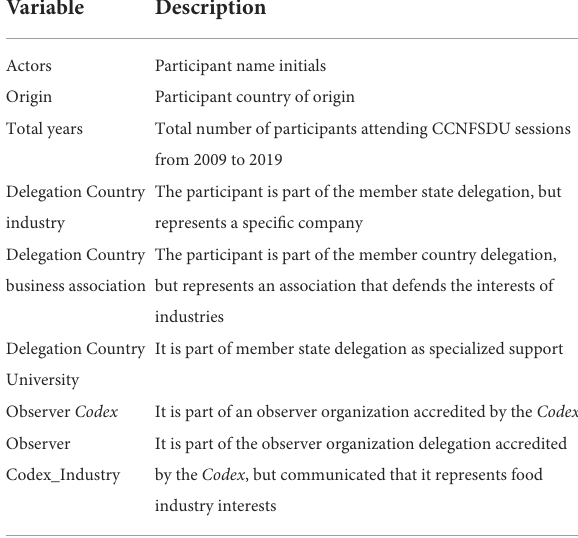
TABLE 2 Variables applied in private interest participants analysis, CCNFSDU a , 2009–2019.